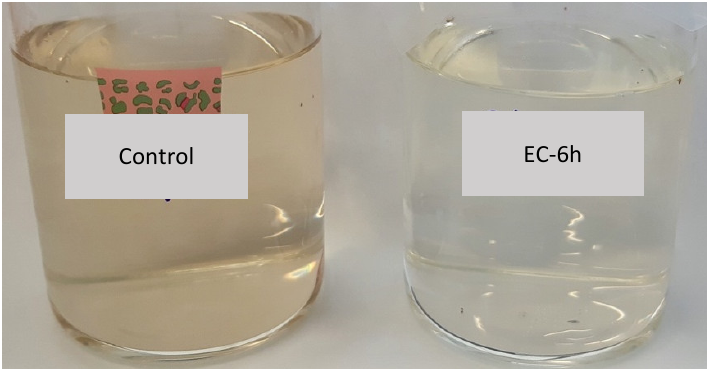
Figure 3. Effluent in the control and after applying electrochemical (EC) treatment for 6 h (EC-6h, Set 1).